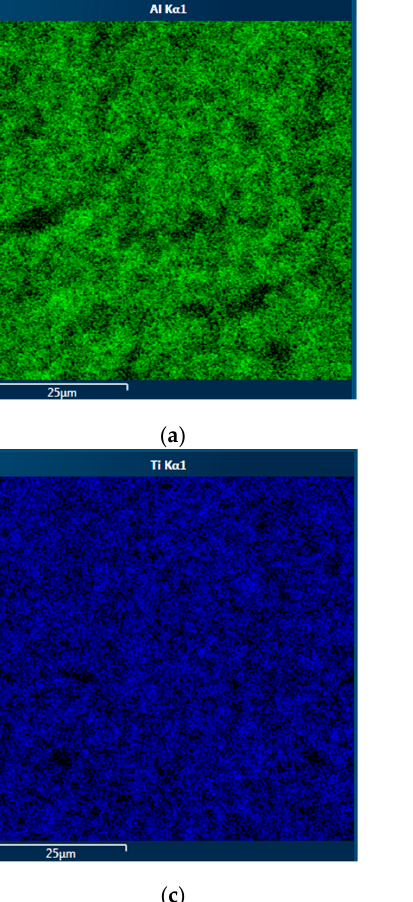
Figure 8. Elemental mapping of the Al 2 O 3 + 30%TiC nanocomposite machined surface in water medium: ( a ) Aluminum; ( b ) Oxygen; ( c ) Titanium; ( d ) Carbon.